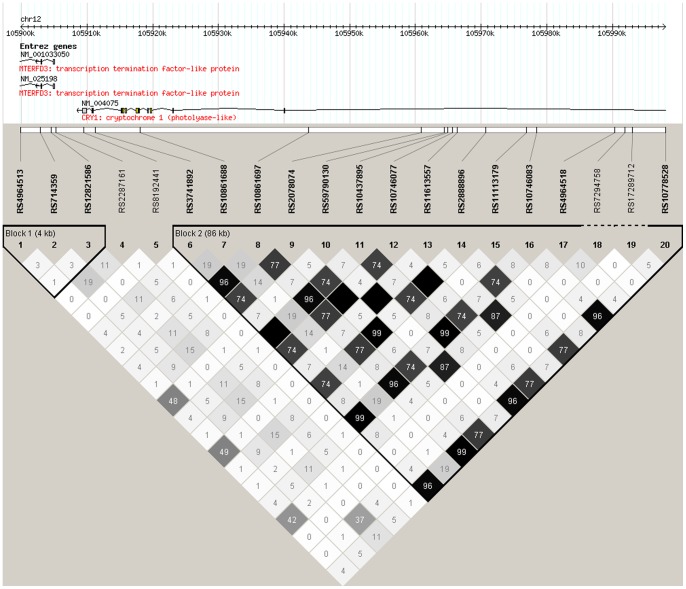
The analyzed CRY1 SNPs in this study, their location and the haplotype block structure of the area formed based on our sample showing r2 values.The confidence interval algorithm implemented in the Haploview program was used to construct the haplotype blocks.